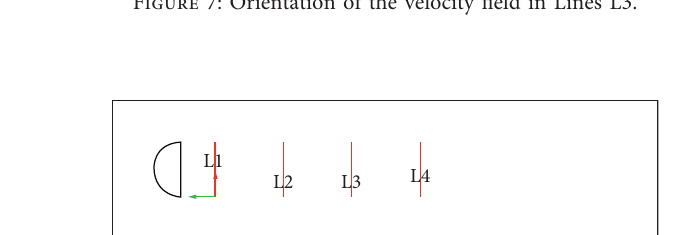
Figure 8: View of vertical